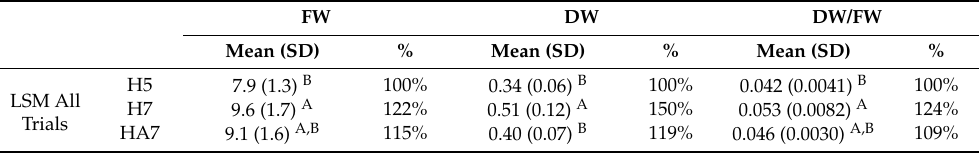
Table 6. Least squares means (LSM) for root mean, standard deviation (SD), and percentage comparison to H5 response for fresh weight (FW, g), dry weight (DW, g), and dry weight to fresh weight ratio (DW/FW, g / g ) with multi-model significance. Root mass does not include root mass within the rockwool cube. Differing superscript letters within response variables (columns) denote significance at α =